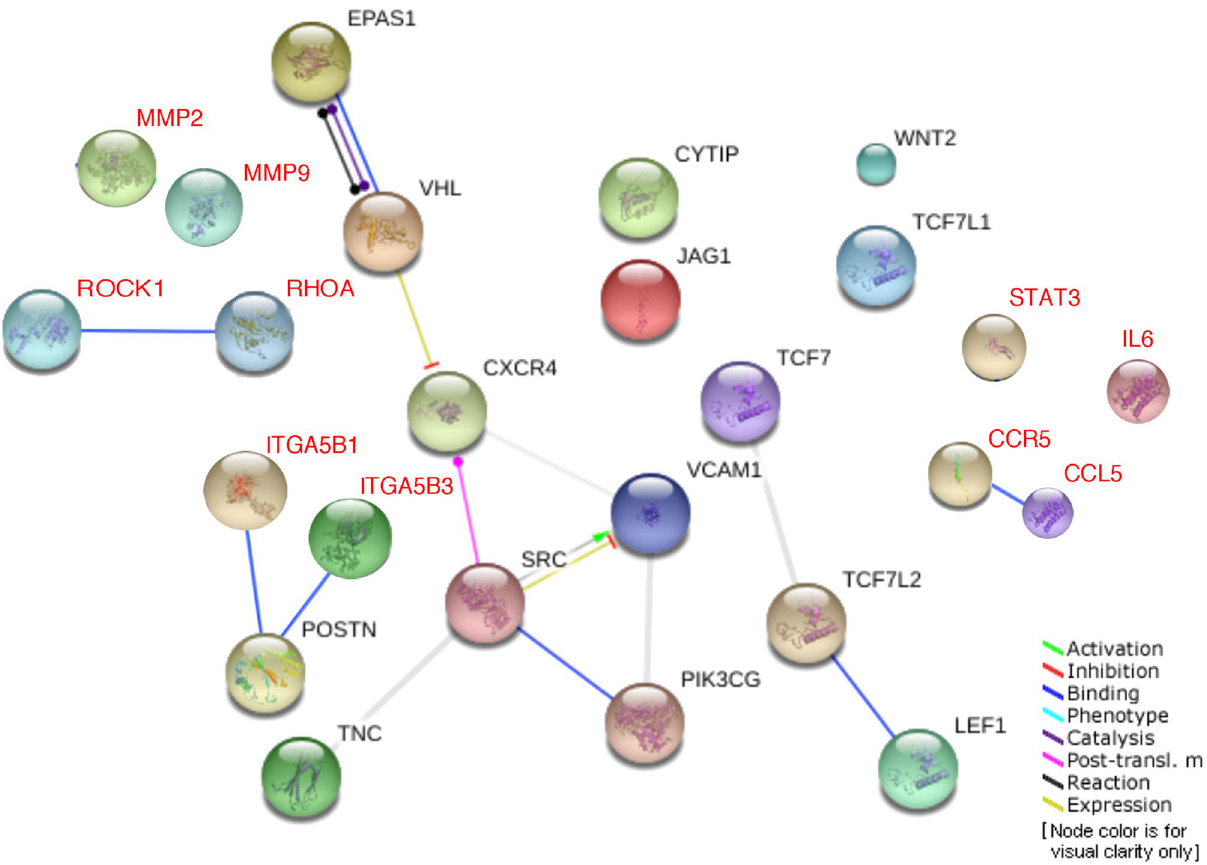
Figure 5. Network of genes for periostin. Screenshot from PathCards displaying seventeen SuperPath genes (black text) functionally connected to periostin and ten additional genes, known to be related to or influencing periostin signalling (red text). The protein nodes and the inter-connections within the retrieved network are automatically coloured for visual clarity and also to indicate the type of functional connectivity. The genes displayed in this figure are: C-X-C Motif Chemokine Receptor 4 (CXCR4); Cytohesin 1 Interacting Protein (CYTIP); Endothelial PAS Domain Protein 1 (EPAS1); Jagged Canonical Notch Ligand 1 (JAG1); Lymphoid Enhancer Binding Factor 1 (LEF1); Periostin (POSTN); Phosphatidylinositol-4,5-Bisphosphate 3-Kinase Catalytic Subunit Gamma (PIK3CG); SRC Proto-Oncogene, Non-Receptor Tyrosine Kinase (SRC); Tenascin C (TNC); Transcription Factor 7 (TCF7); Transcription Factor 7 Like 1 (TCF7L1); Transcription Factor 7 Like 2 (TCF7L2); Vascular Cell Adhesion Molecule 1 (VCAM1); Von Hippel-Lindau Tumor Suppressor (VHL); Wnt Family Member 2 (WNT2), Rho-associated protein kinase 1 (ROCK1), Ras Homolog Family Member A (RHOA), C–C chemokine receptor type 5 (CCR5), C–C Motif Chemokine Ligand 5 (CCL5), Matrix metalloproteinase-2 (MMP2), Matrix metalloproteinase-9 (MMP9) Signal transducer and activator of transcription 3 (STAT3), Interleukin 6 (IL-6) Integrin alpha V beta 1 & 3 (ITGA5B1&3). The screenshot was taken from the following url in April 2018. https ://pathc ards.genec ards.org/Card/ampli ficat ion_and_expan sion_of_oncog enic_pathw ays_as_metas tatic _trait s?query Strin g=POSTN The screenshot database is based on a publication from Belinky et al. 36 and was modified based on results in recent publications 6,39